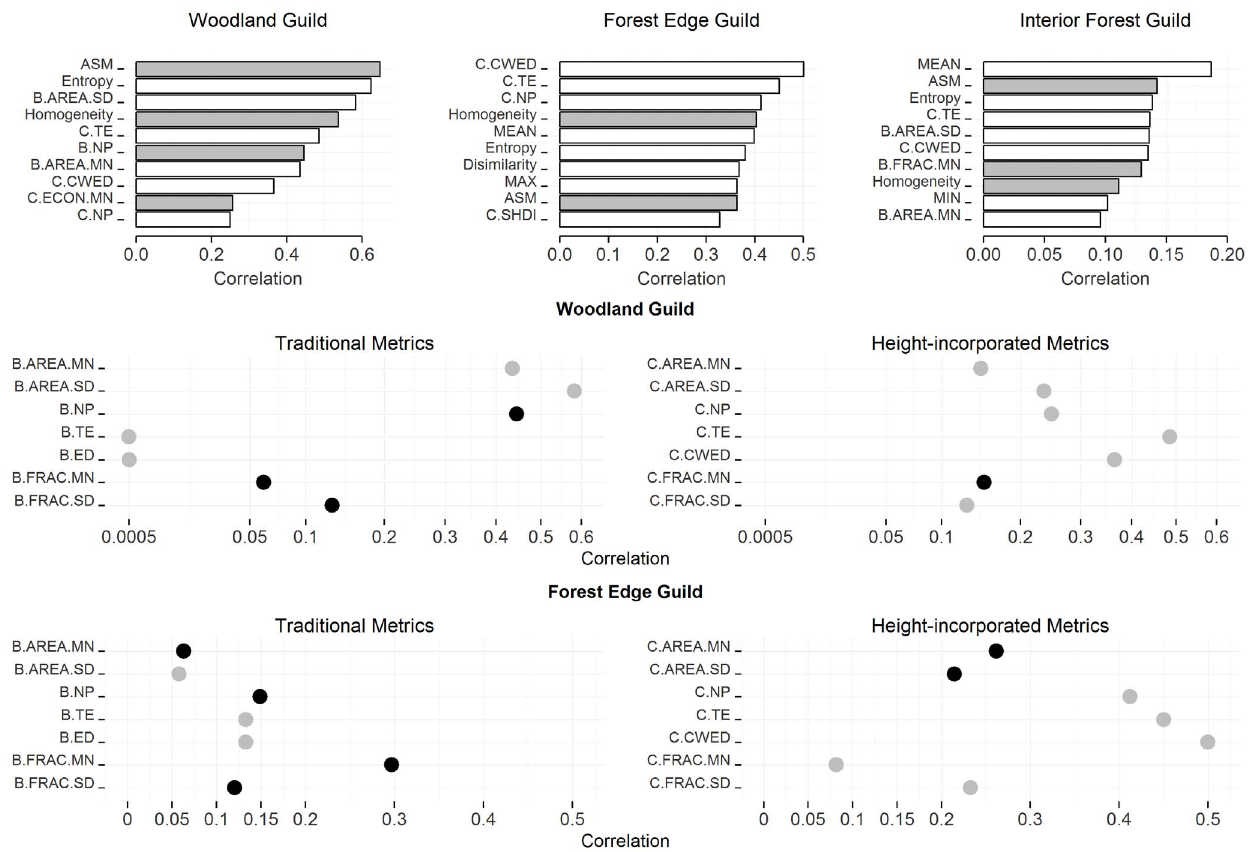
Figure 3. Guild richness associations with various metrics. (Top row): correlation bar plots of the most predictive metrics of species richness by guild. White bars represent a positive correlation and grey indicate a negative correlation. (Bottom rows): correlation comparisons between comparable patch-based metrics with and without considering the vertical patches and edges for the woodland and forest edge guild. The left panels show traditional metrics without accounting for height-heterogeneity; the right panels are height-structured counterparts. The black dots indicate a negative correlation and the grey ones indicate a positive correlation.